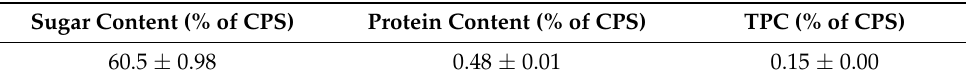
Table 1. Chemical composition of S. crispa crude polysaccharides (CPS). Abbreviations: TPC–total phenolic content.